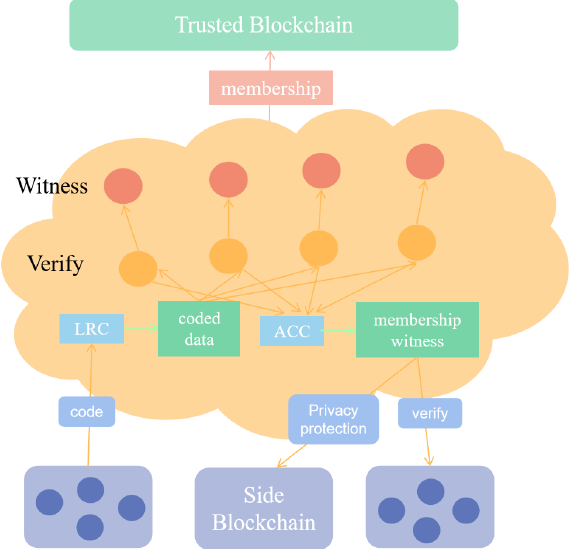
Figure 2. Intermediate verification